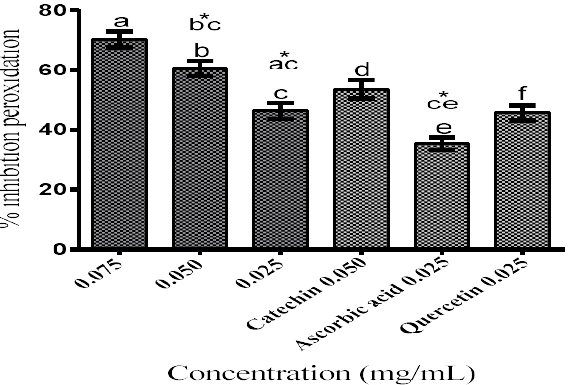
Figure 1. Inhibition of lipid peroxidation in homogenate of whole Drosophila melanogaster flies exposed to Fe 2+ overload and treated with TFSR at different concentrations. The values are expressed as means ± S.E.M ( n = 3) as calculated by one-way ANOVA followed by Tukey’s multiple comparisons test with a single pooled variance ( p < 0.05; 95% confidence interval). Bars with letters a, b, and c represent TFSR concentrations, and d, e, and f represent catechin, ascorbic acid, and quercetin concentrations, respectively. “*” indicate significant differences between TFSR concentrations and control substances.